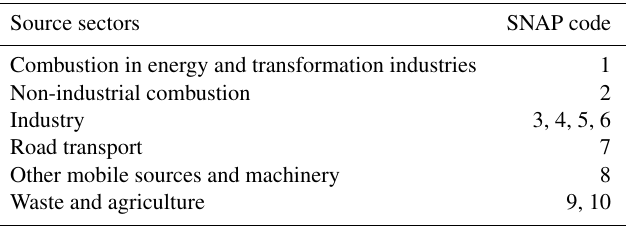
Table 3. Source sectors used in the perturbation scenarios. Source sectors